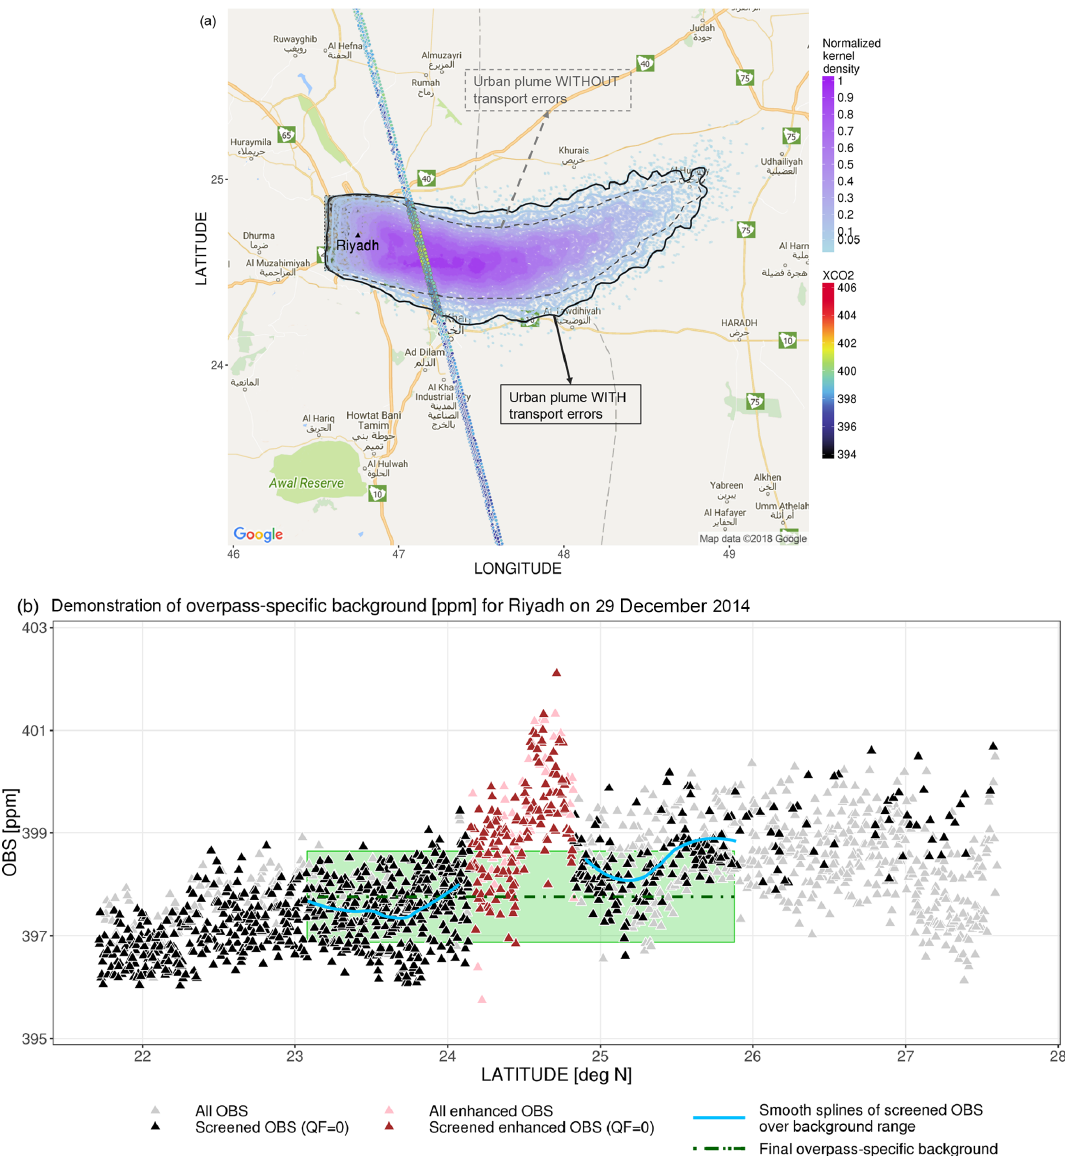
Figure 5. Demonstration of the overpass-specific background using the 29 December 2014 overpass for Riyadh as an example. (a) Forward particle distributions with random transport error included (blue and purple dots) and their derived normalized kernel density (solid purple contours) during the OCO-2 overpass time ( ∼ 3mins) with observed XCO 2 (blue to red dots). Urban plumes are defined based on 5% of the max 2-D kernel density estimated from parcels’ distributions without (gray dashed line) and with (black solid line) transport errors. (b) Latitude-series of observed XCO 2 with the demonstration of background estimates. Smooth splines (solid blue lines) are drawn to visually reveal the variation of observed XCO 2 over the background latitudinal band. The background uncertainty (green shaded area) includes both the spatial uncertainty and the retrieval uncertainty of observations over the background latitude